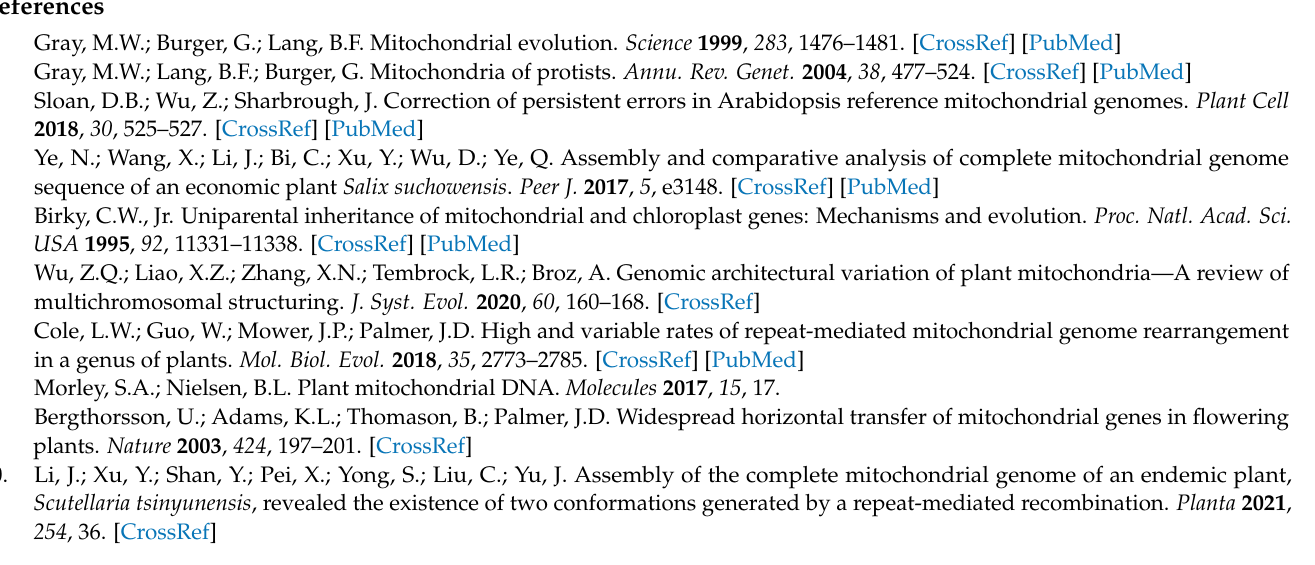
Figure S3. Yield quantities of kiwifruit in the world from 1999 to 2020; Figure S4. Production share of kiwifruits by region; Figure S5. Production of kiwifruit, including the top 10